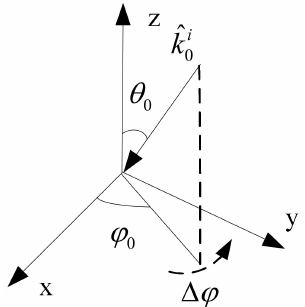
Figure 9. Incidence in small angle